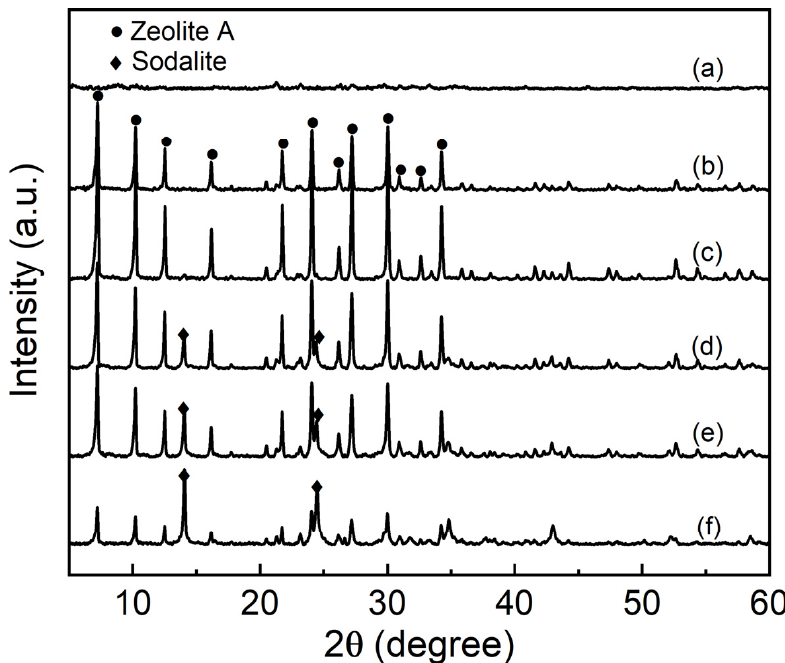
Figure 2. XRD patterns of samples synthesized at different NaOH concentrations (NaOH concen- trations: ( a ) 0.25 mol·L − 1 , ( b ) 0.5 mol·L − 1 , ( c ) 1.0 mol·L − 1 , ( d ) 1.5 mol·L − 1 , ( e ) 2.0 mol·L − 1 and ( f ) 2.5 mol·L − 1 ).